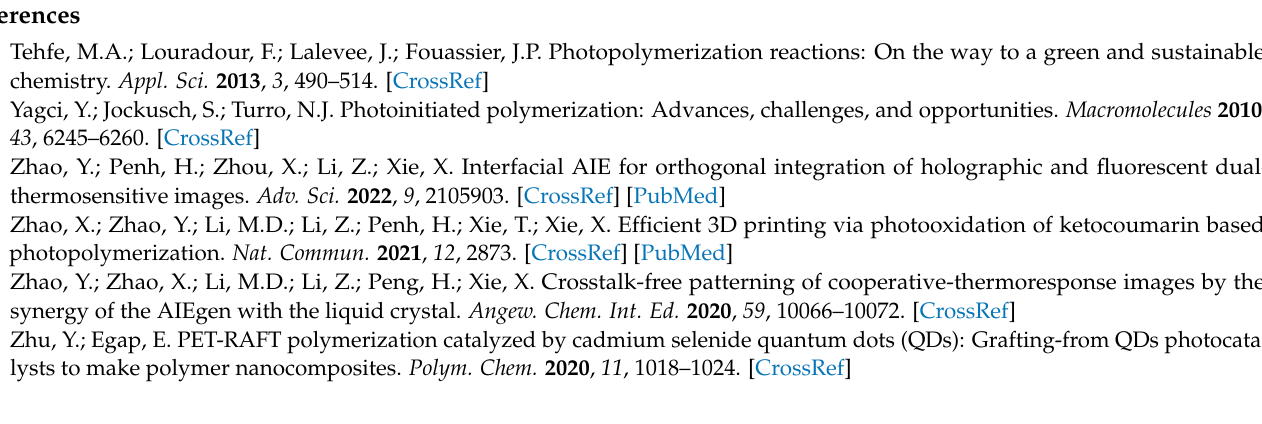
Figure S3: 1H NMR of the NA-3. Figure S4: 1H NMR of the NA-4. Figure S5: 13C NMR of the NA-1. Figure S6: 13C NMR of the NA-2. Figure S7: 13C NMR of the NA-3. Figure S8: 13C NMR of the NA-4. Figure S9: Fourier-transfer mass spectrometry (FT-MS) of the NA-1. Figure S10: Fourier-transfer mass spectrometry (FT-MS) of the NA-2. Figure S11: Fourier-transfer mass spectrometry (FT-MS) of the NA-3. Figure S12: Fourier-transfer mass spectrometry (FT-MS) of the